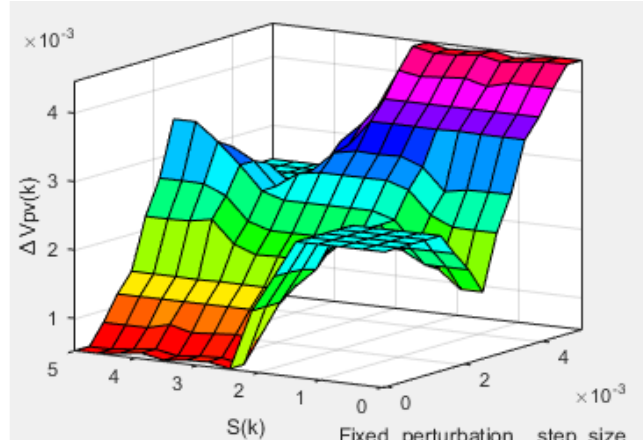
Figure 5. Mesh plot of the input and output mapping of the relationship between the fixed perturbation voltage step size and the measured PV curve slope S ( k ) and the output variable step ∆V pv ( k ).